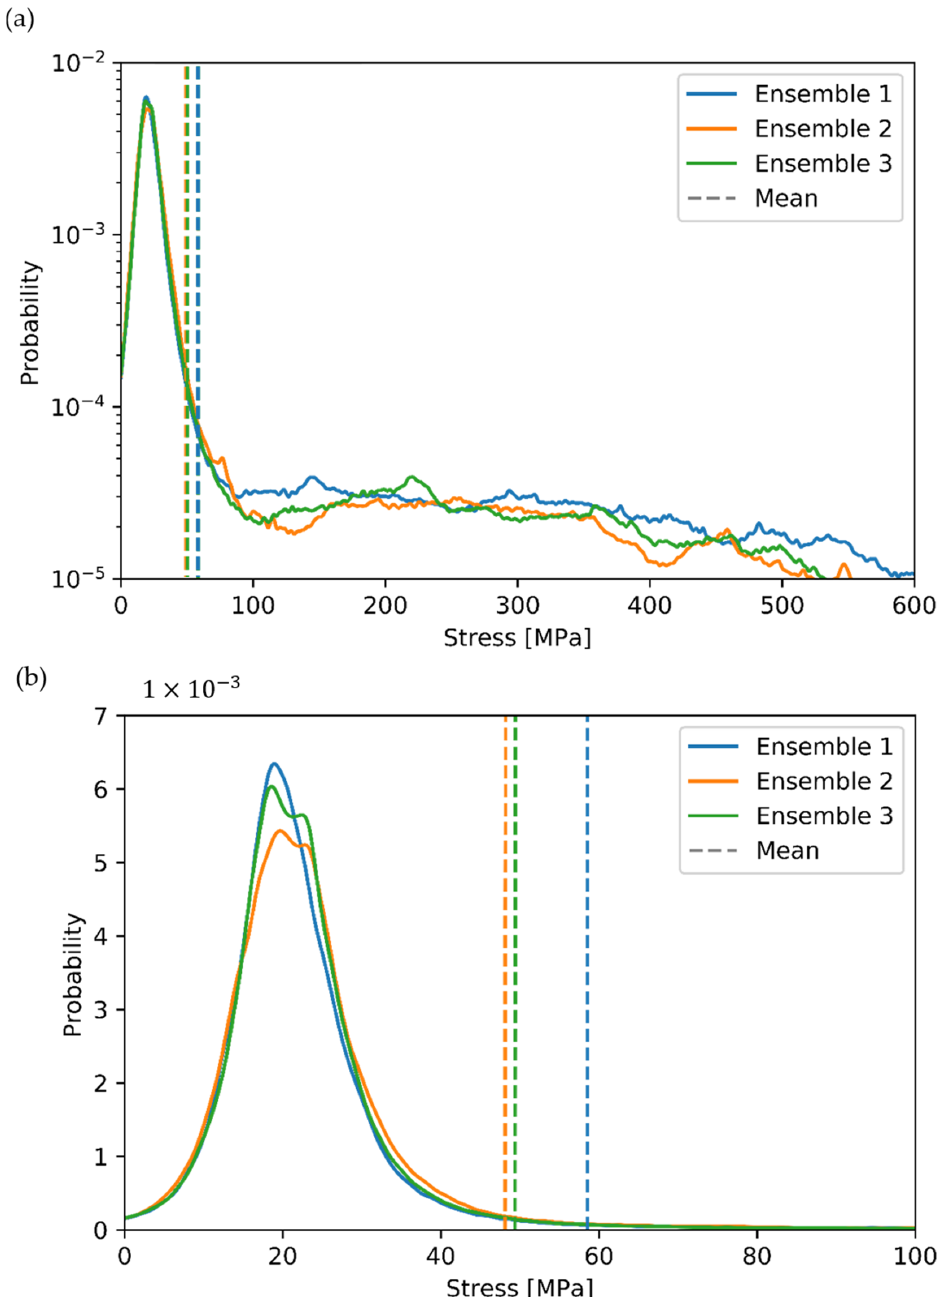
Figure 10. ( a ) Stress distribution of three unique fiber ensembles (top), ( b ) Stress distribution of the matrix phase of the same ensembles (bottom).